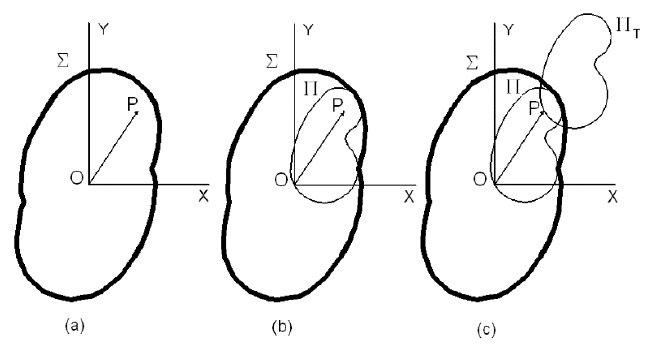
→ OP is included in Σ , Π and Π T Figure A1. Demonstration sequence: If Figure A1. Demonstration sequence: If 𝑂𝑃⃗⃗⃗⃗⃗⃗ is included in 𝛴 , 𝛱 and 𝛱 𝑇 intersect.